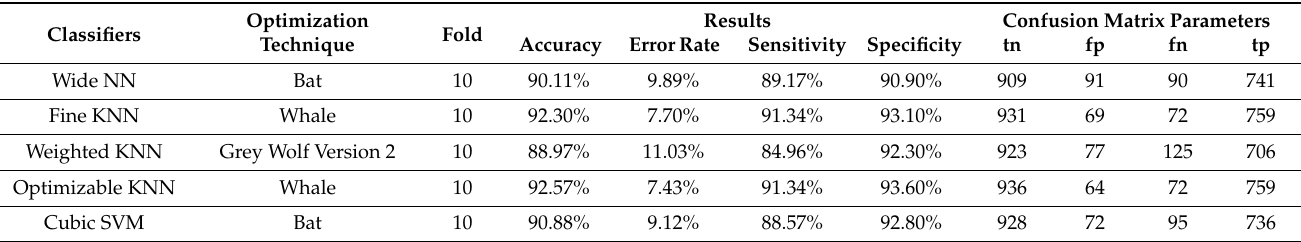
Table 4. Performance of various classifiers using GLCM features.